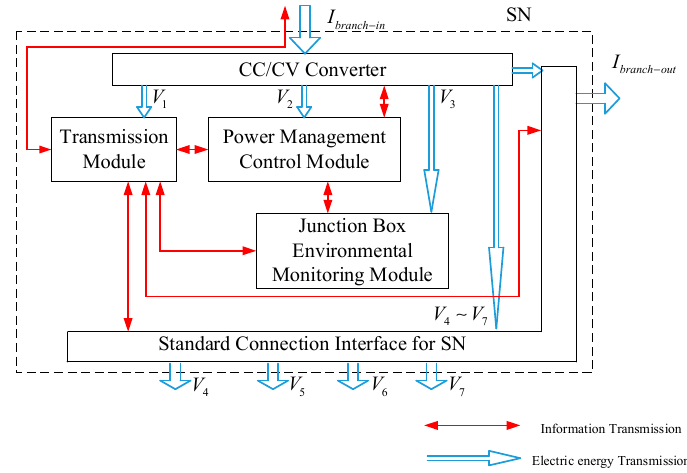
Figure 2. Internal structure diagram of the equipment in primary nodes (PNs).